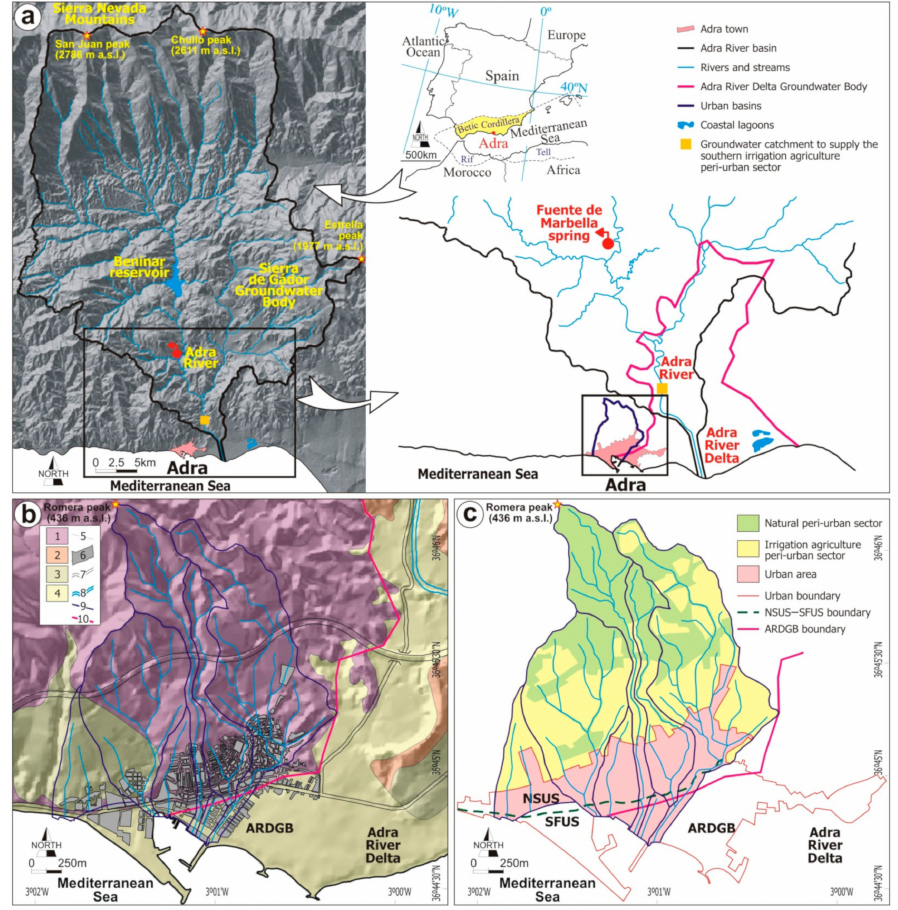
Figure 1. ( a ) Location of the study area in southern Spain, showing geographical sites cited in the text. ( b ) After the Geological Survey of Spain [38], the simplified 1:50,000-scale geological map of the urban and peri-urban areas; legend as (1) Paleozoic metamorphic formations, (2) Pliocene formations, (3) Pleistocene formations, (4) Holocene formations, (5) Undifferentiated geological contact, (6) Urban area, (7) Roads, (8) Adra River, (9) Urban basins, and (10) ARDGB boundary. ( c ) After the Andalusian Environmental Information Network [http://www.juntadeandalucia.es/medioambiente/site/rediam], the 1:25,000 scale land-use map of the urban basins, accessed on 15 January